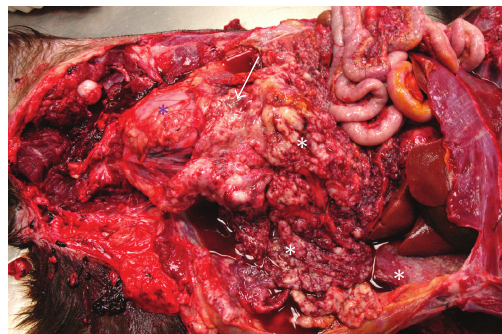
Figure 5: Gross image from the necropsy examination. Note the large abdominal mass (blue arrow) with extensive intra-abdominal dissemination (white asterisks: sarcomatosis). The urinary bladder is indicated by the blue